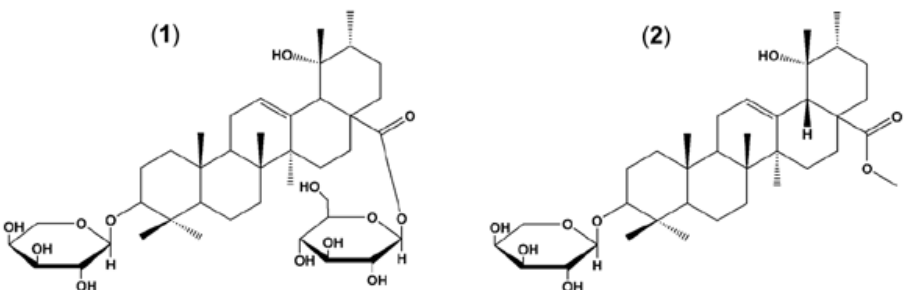
Figure 1. Structure of ziyuglycoside I and ziyuglycoside II methyl ester. ( 1 ) ziyuglycoside I (ZG01); ( 2 ) ziyuglycoside II methyl ester (ZG02-ME).